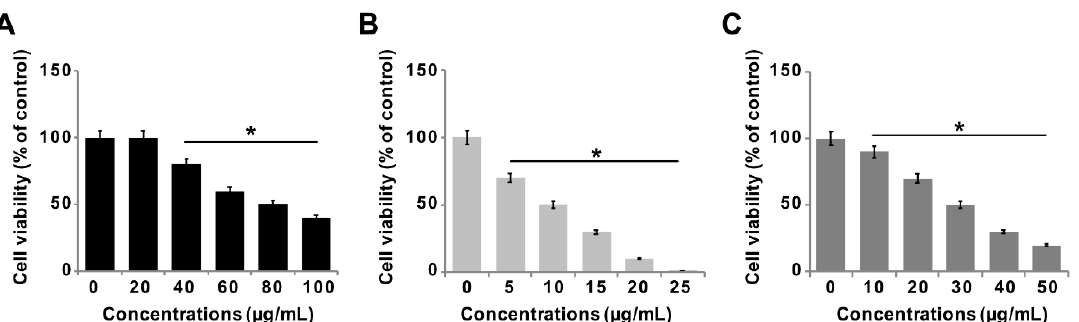
Figure 6. GO, GO-PtNPs, and PtNPs inhibit cell viability of LNCaP cells. The viability of LNCaP cells was determined after 24-h exposure to different concentrations of GO ( A ), GO-PtNPs ( B ), and PtNPs ( C ) using CCK-8. The treated groups showed statistically significant differences from the control group by the Student’s t -test (* p < 0.05).